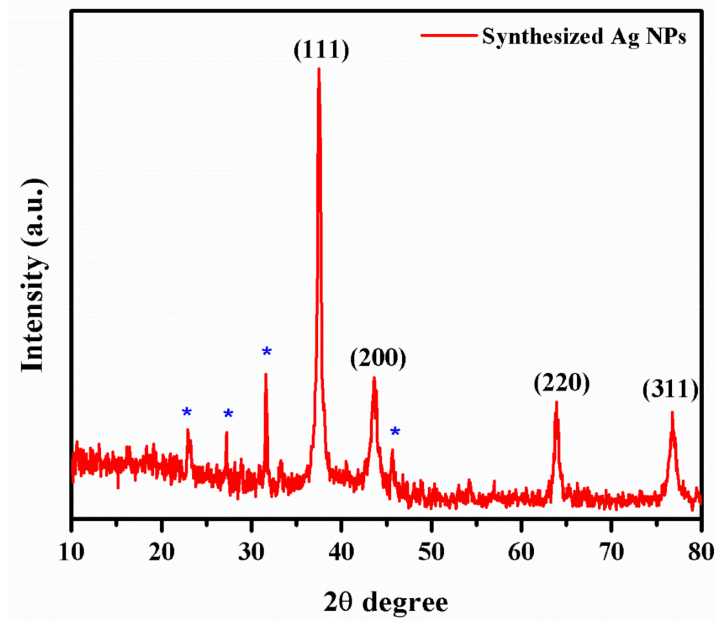
Figure 4. XRD analysis of Ag NPs.